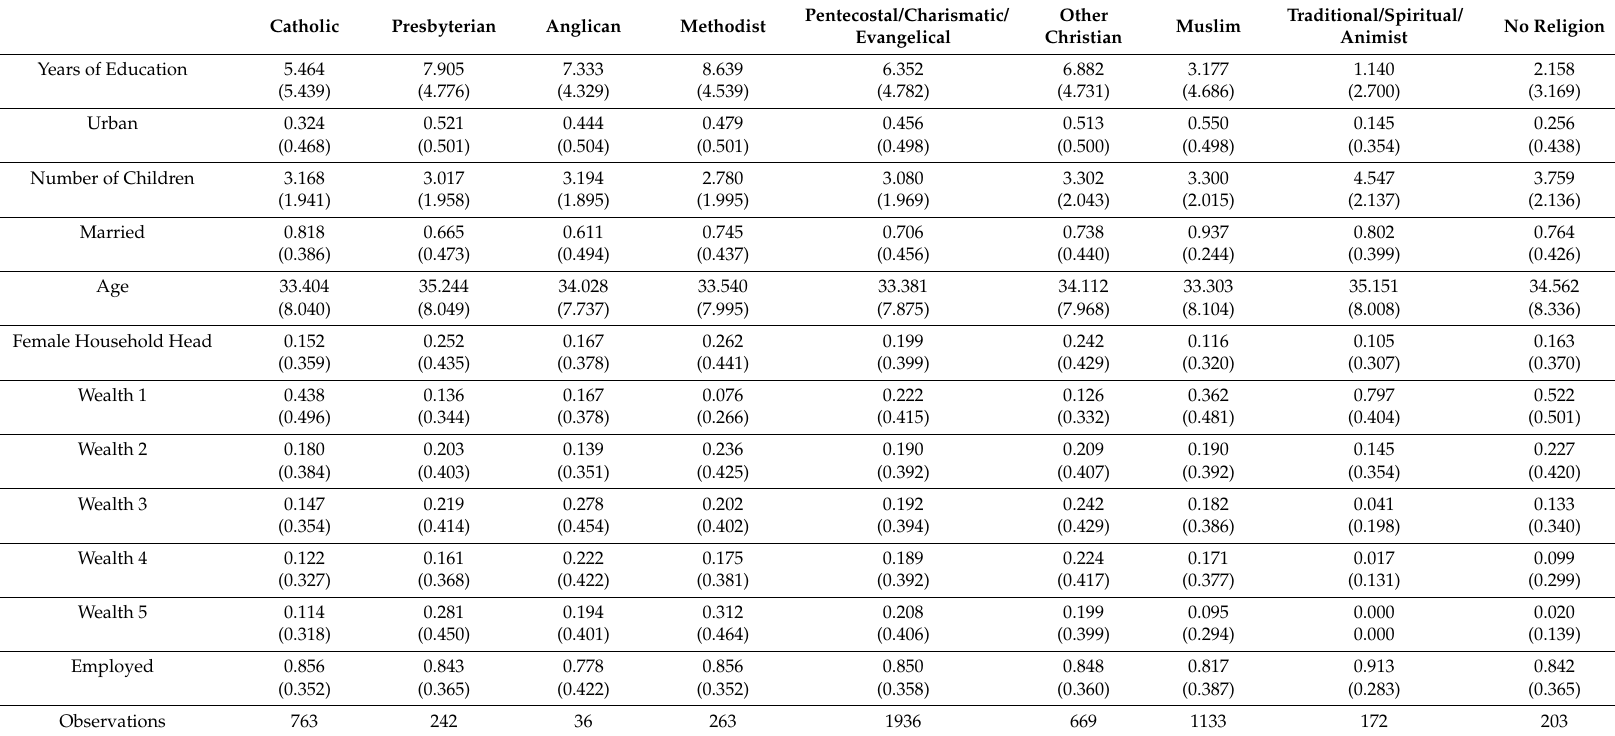
Standard deviations in parentheses. Regional dummy variables also included in